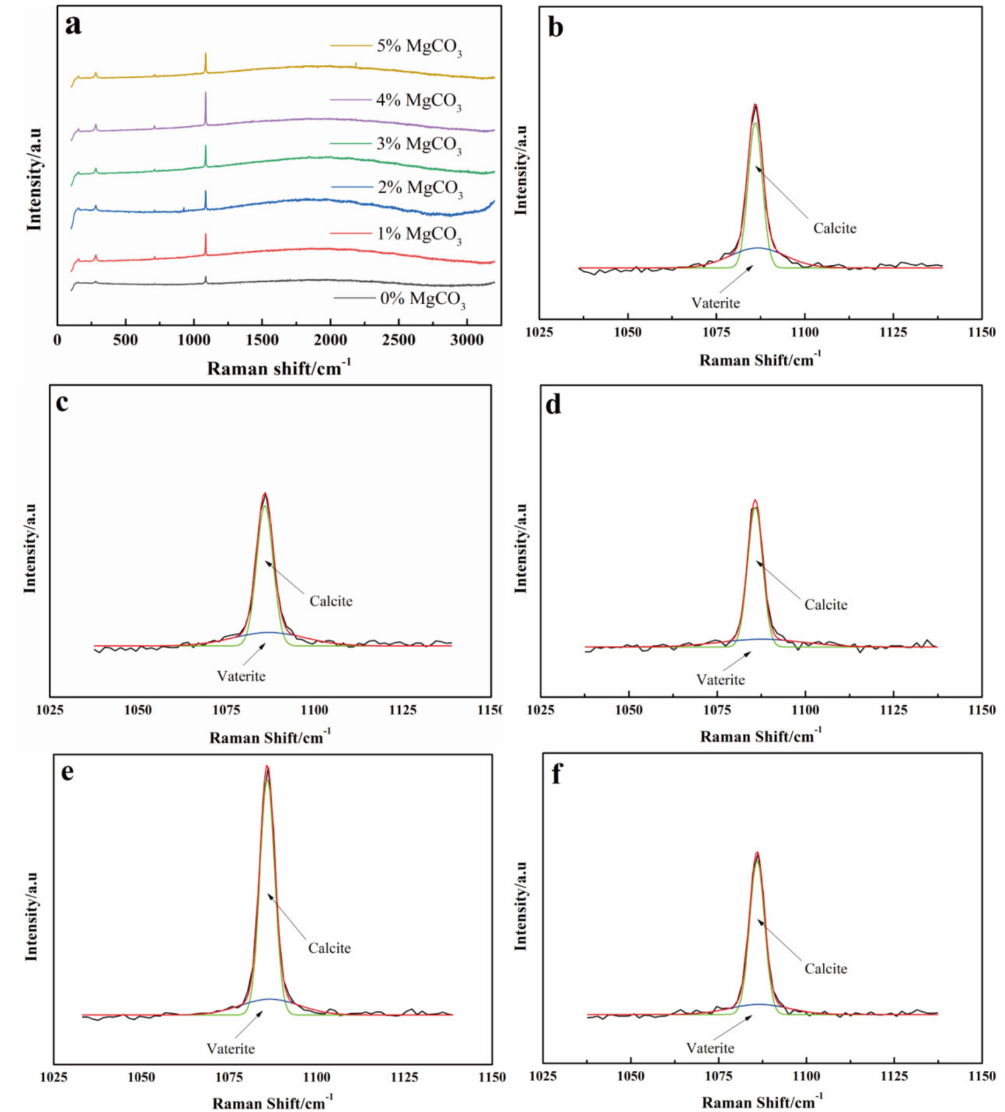
Figure 8. A full spectrum and thorough analysis of the magnetized anti-scaling products with di ff erent magnesium carbonate dosage: ( a ) full spectrum; ( b ) 1%; ( c ) 2%; ( d ) 3%; ( e ) 4%; ( f )